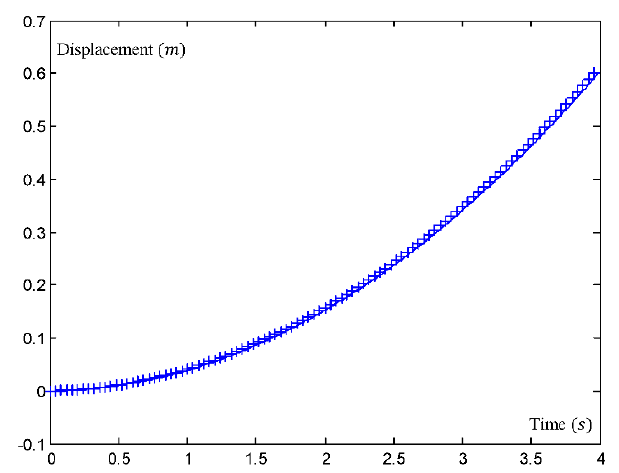
Figure 7. Translation according to yR.